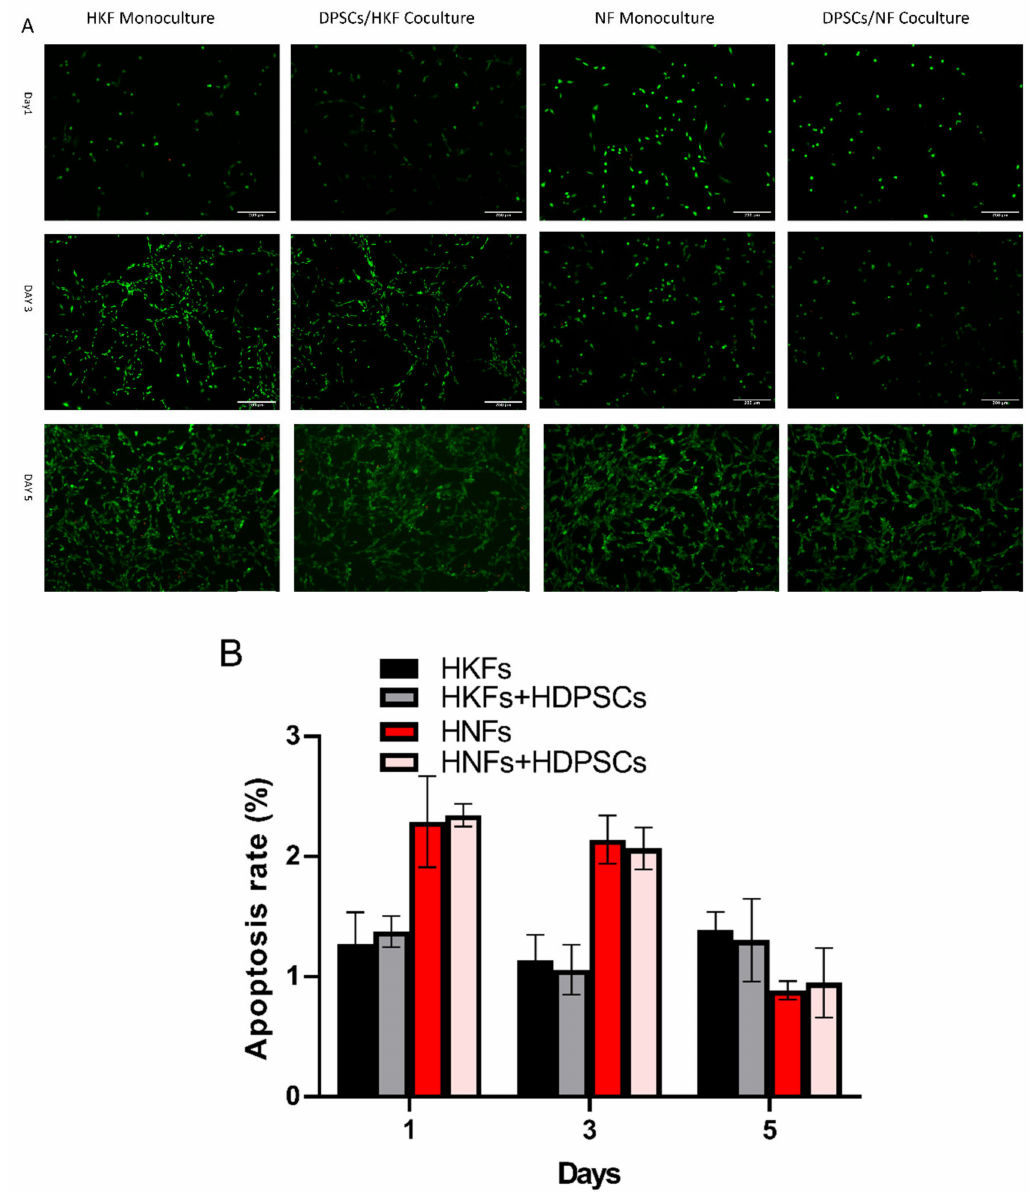
Figure 5. Apoptosis rate of HNFs and HKFs in mono and co-cultures. HDPSCs do not induce apoptosis in HNFs or HKFs. ( A ): Vital cells stain green with Calcein-AM, while dead cells stain red with propidium iodide on days 1, 3, and 5. Scale bar: 200 µ m. ( B ): The quantification of cell apoptosis/necrosis using the percentage of PI-positive cells/AM-positive cells. (Mean q-SD, n = 5, Student t -test, p <